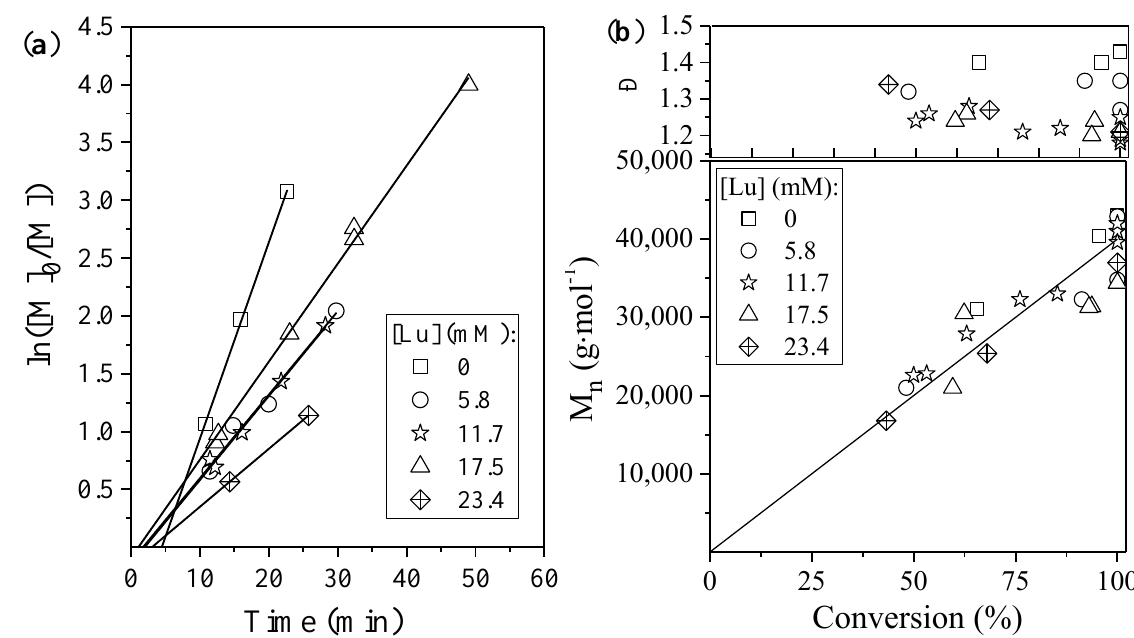
Figure 3. ( а ) First-order plots and ( b ) M n , Đ vs. conversion dependences for cationic polymerization of isobutylene with DiCumCl/TiCl 4 /Lu initiating system in CH 2 Cl 2 /MCH 40:60 v / v at different proton trap concentrations at −8 0 °C: [IB] = 1.0 M; [TiCl 4 ] = 59 mM; [DiCumCl] = 1.4 mM.